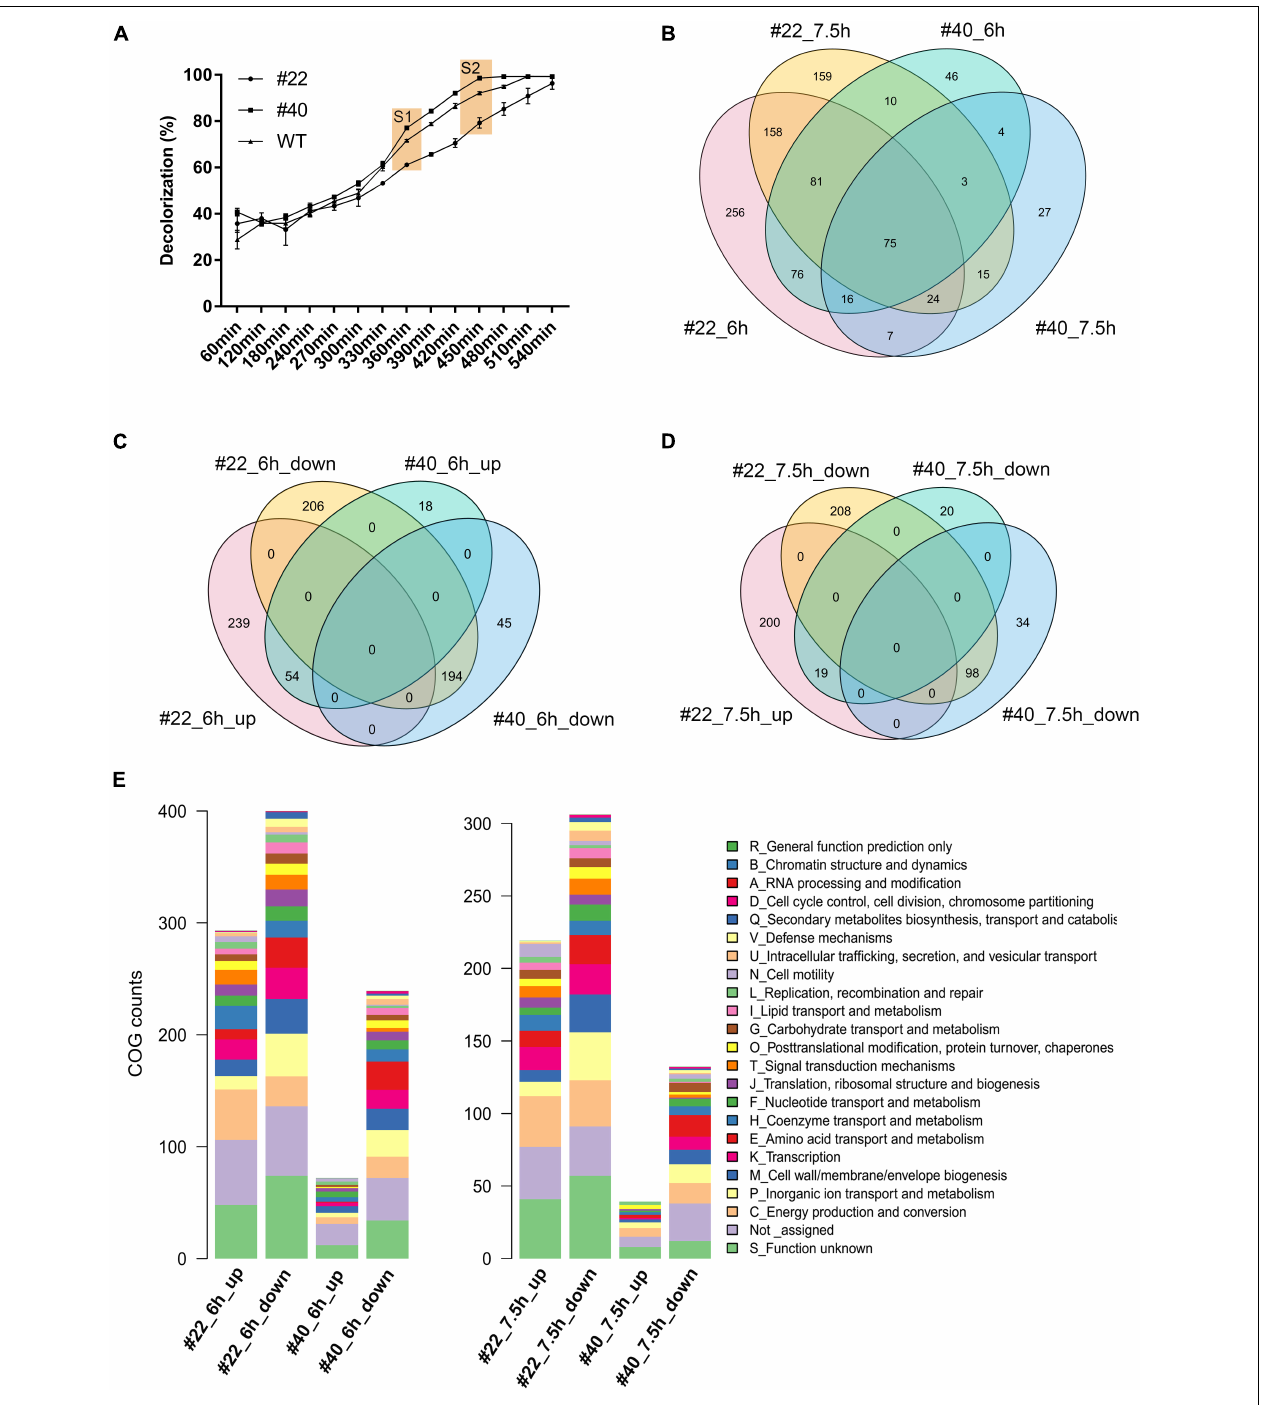
FIGURE 3 | The sampling and profile of the alternation of global gene transcription between strains. S1 and S2 represent the first and second sampling time points, respectively (A) . Venn diagram of DEGs between different strains at different time points (B–D) . COG function of the DEGs in the mutants at different sampling time points (E)